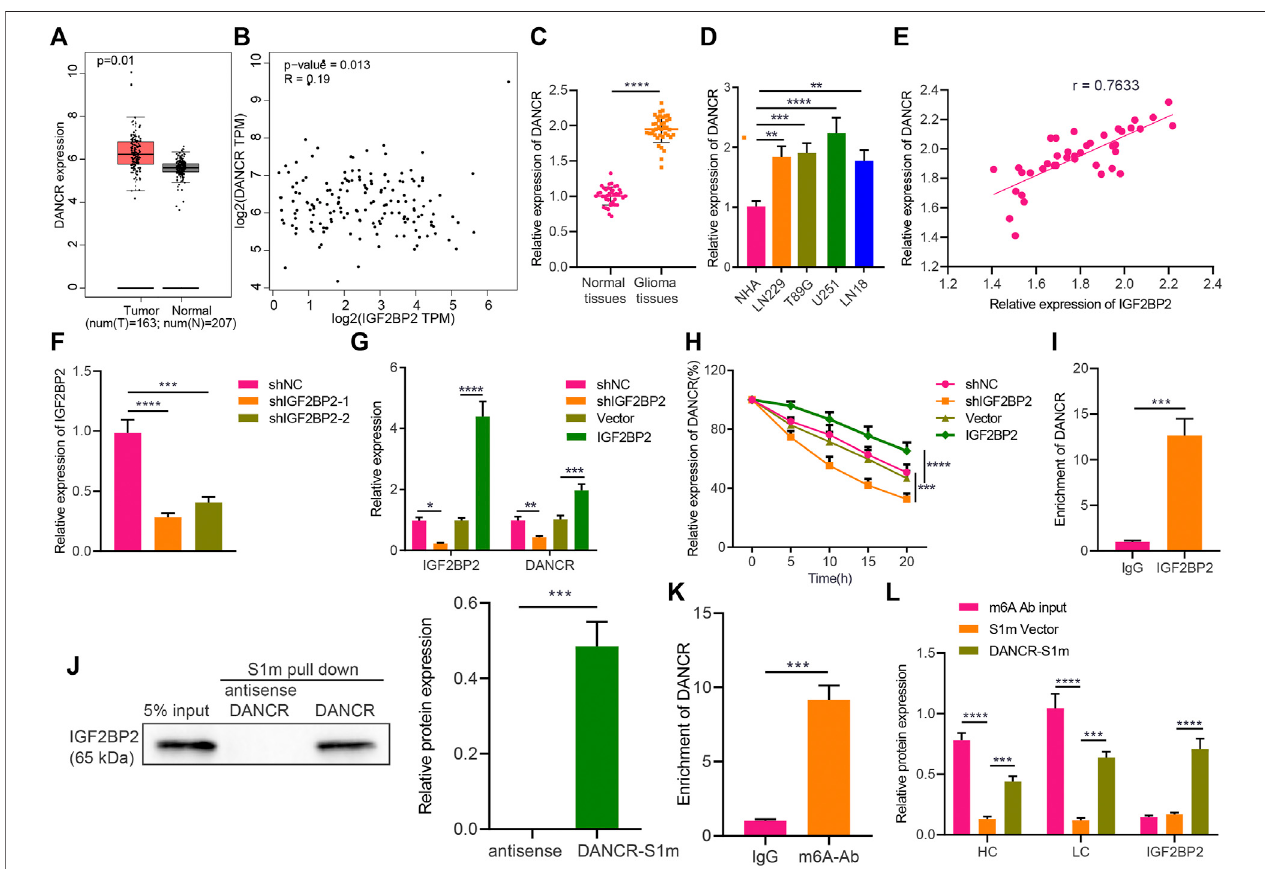
FIGURE 2 | IGF2BP2 enhances stability of DANCR in GBM cells. (A) GEPIA analysis of DANCR expression in glioma samples. (B) Correlation between IGF2BP2 and DANCR genes in TCGA database-based glioma samples (n (cid:1) 163) analyzed by GEPIA. (C) RT-qPCR analysis of DANCR mRNA expression in glioma tissues and normal brain tissues. (D) RT-qPCR analysis of DANCR mRNA expression in GBM cell lines (U251MG, LN229, LN18, T98G) and the primary normal human astrocyte NHA cell line. (E) Pearson correlation coef fi cient analysisbetweenIGF2BP2and DANCRinglioma tissues. (F) RT-qPCRanalysisofef fi ciency ofIGF2BP2 silencing inU251cellsupontreatmentwithsh-IGF2BP2-1orsh-IGF2BP2-2. (G) RT-qPCRanalysisofDANCRmRNAexpression inU251cellsupontreatmentwithsh-IGF2BP2, vector, sh-NC, or IGF2BP2. (H) RT-qPCR analysis of DANCR mRNA expression in U251 cells upon treatment with sh-IGF2BP2, vector, sh-NC, or IGF2BP2 following actinomycin D treatment. (I) RIP assay of DANCR enrichment with IGF2BP2 antibody or IgG in U251 cells. (J) Western blot analysis of IGF2BP2 in the DANCR complex pulleddownbystreptavidinmagneticbeadsinU251cellstransfectedwithpHAGE-S1m-DANCRplasmids.Inputreferstothewholecelllysate. (K) RIPassayofDANCR enrichment with m6A antibody or IgG in U251 cells. (L) Western blot analysis ofIGF2BP2 expression in the pull-down complex ofU251 cells treated with DANCR-S1m, m6A antibody, input, or S1m vector. HL indicates heavy chain and LC indicates light chain. * p < 0.05, ** p < 0.01, *** p < 0.001, **** p < 0.0001. Values shown represent mean ± standard deviation of three independently performed experiments. Data between two groups were compared by unpaired t test. Multigroup data comparison wasconductedbyone-wayANOVAfollowedbyTukey posthoc test.Dataamonggroupsatdifferenttimepointswerecomparedbytwo-wayANOVA,followedbyTukey post hoc